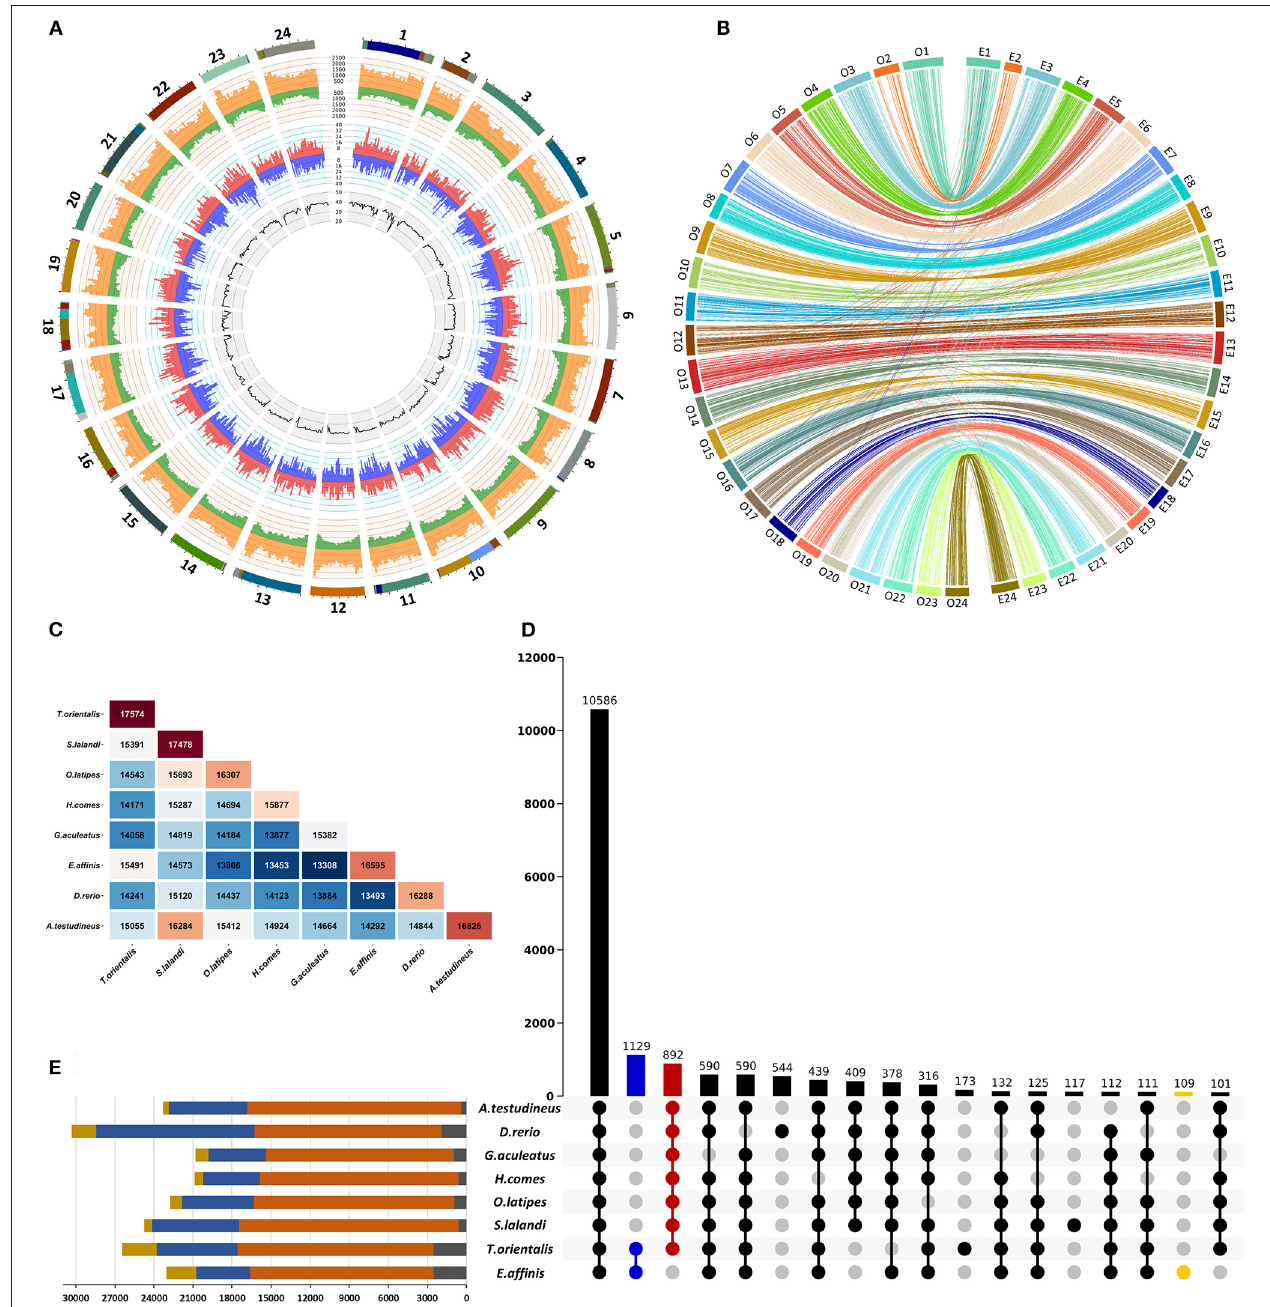
FIGURE 1 | Characterization of the draft genome assembly of kawakawa Euthynnus affinis . (A) Summary of the genome annotation of kawakawa Euthynnus affinis . The tracks from inside to outside: GC content (%), negative-strand gene abundance (blue), positive-strand gene abundance (red), negative strand repetitive DNA abundance (green), positive-strand repetitive DNA abundance (orange), 24 pseudochromosomes (colors within each pseudochromosome denote different scaffolds). Window size = 1Mb. (B) Chromosome level synteny between kawakawa Euthynnus affinis (right) and Japanese rice fish Oryzias latipes (left) based on 2,989 single-copy orthologs. (C) Number of orthogroups shared between each species pair of eight fish. (D) UpSet plot of intersections between orthogroups in different species. The bars show the number of common orthogroups for a given species or a group of species (dots connected by lines below the x -axis). In total, 10,586 orthogroups are common to all species, while 1,129 orthogroups are unique to E. affinis and T. orientalis (blue). Euthynnus affinis– specific orthogroups (109) are shown in yellow. The species lacks 892 orthogroups found in all other species (red). Intersections with fewer than 100 orthogroups are not shown. (E) Orthogroup size and proportion of genes assigned to orthogroups per species. Yellow = number of genes; blue = number of genes in orthogroups; orange = number of orthogroups containing a given species; gray = number of unassigned genes.